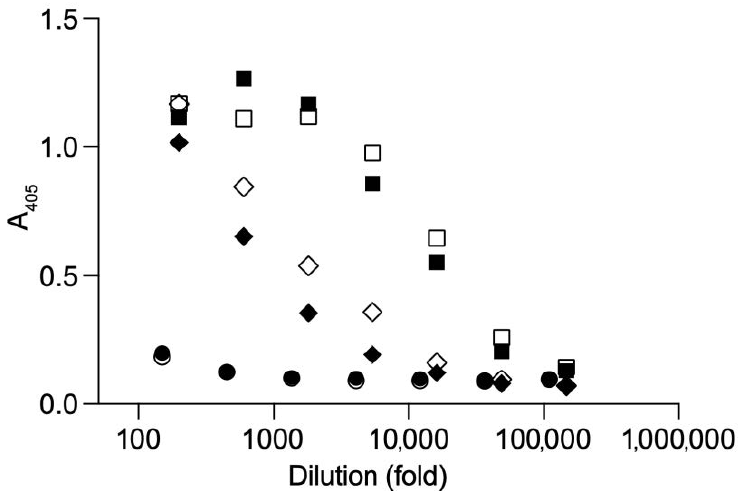
Figure 5. ELISA of two rabbit sera obtained after immunization, including 2 control sera after immunization with a control protein purified using a highly similar procedure. Squares represent day 28 (final bleed) sera from USUV E protein immunized animals, open symbol is serum 710, closed is serum 711. Diamonds represents 2 sera of control protein immunized animals, for which the protein was purified in a highly similar fashion. Circles represent pre-bleed sera from rabbits 710 (open) and 711 (closed). Starting dilution was 1:150.